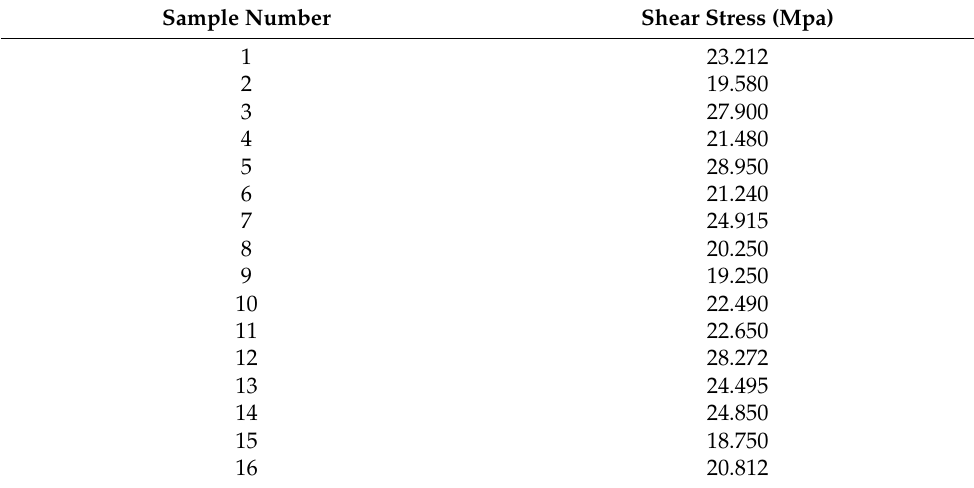
Table A5. Results of shear stress for all